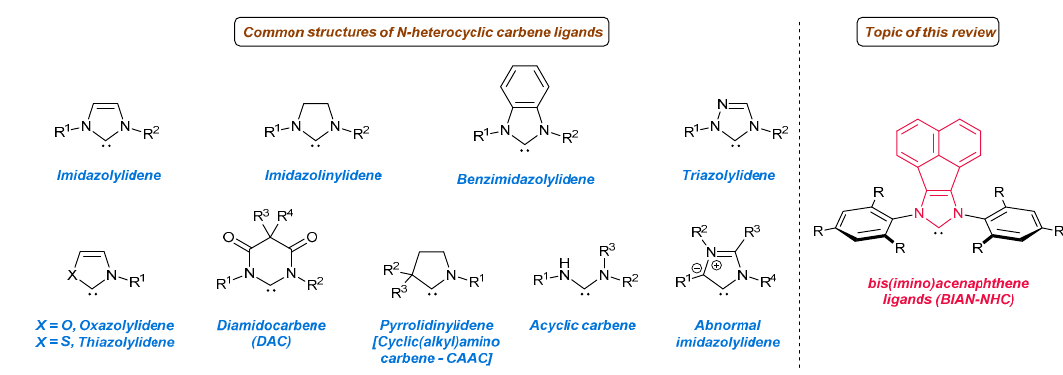
Figure 1. The structure of commonly used NHC and BIAN-NHC ligands.